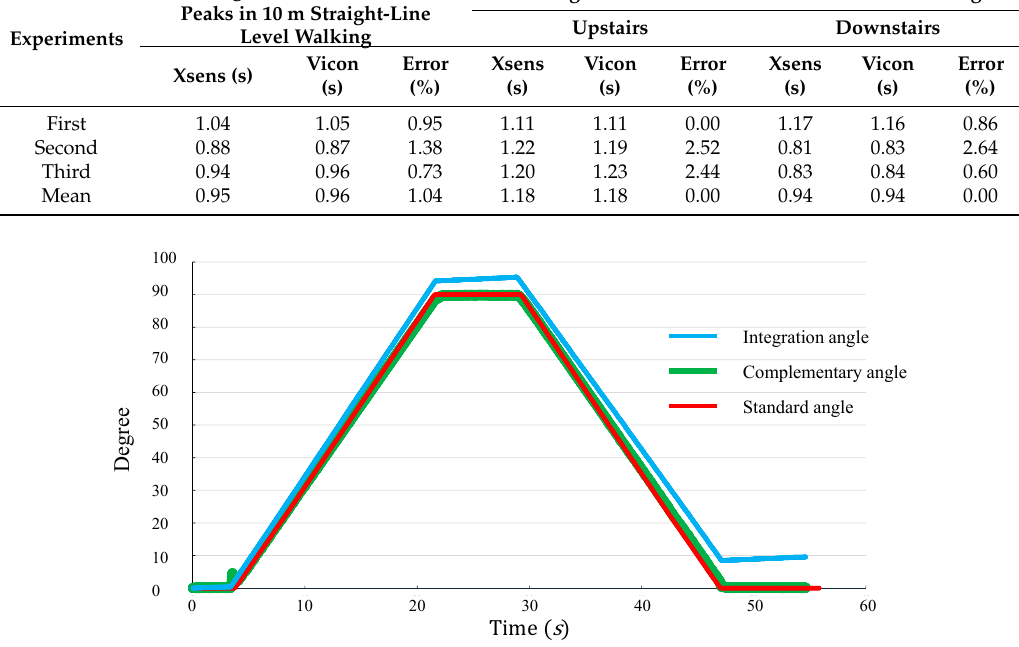
Figure 7. Effect of gyroscope rotation validation. The first curve was calculated by integrating the rotation velocity of the gyroscope, the second curve was calculated by using the complementary filter (Equation (3)), and the third curve was the angle of the step motor (gold standard).